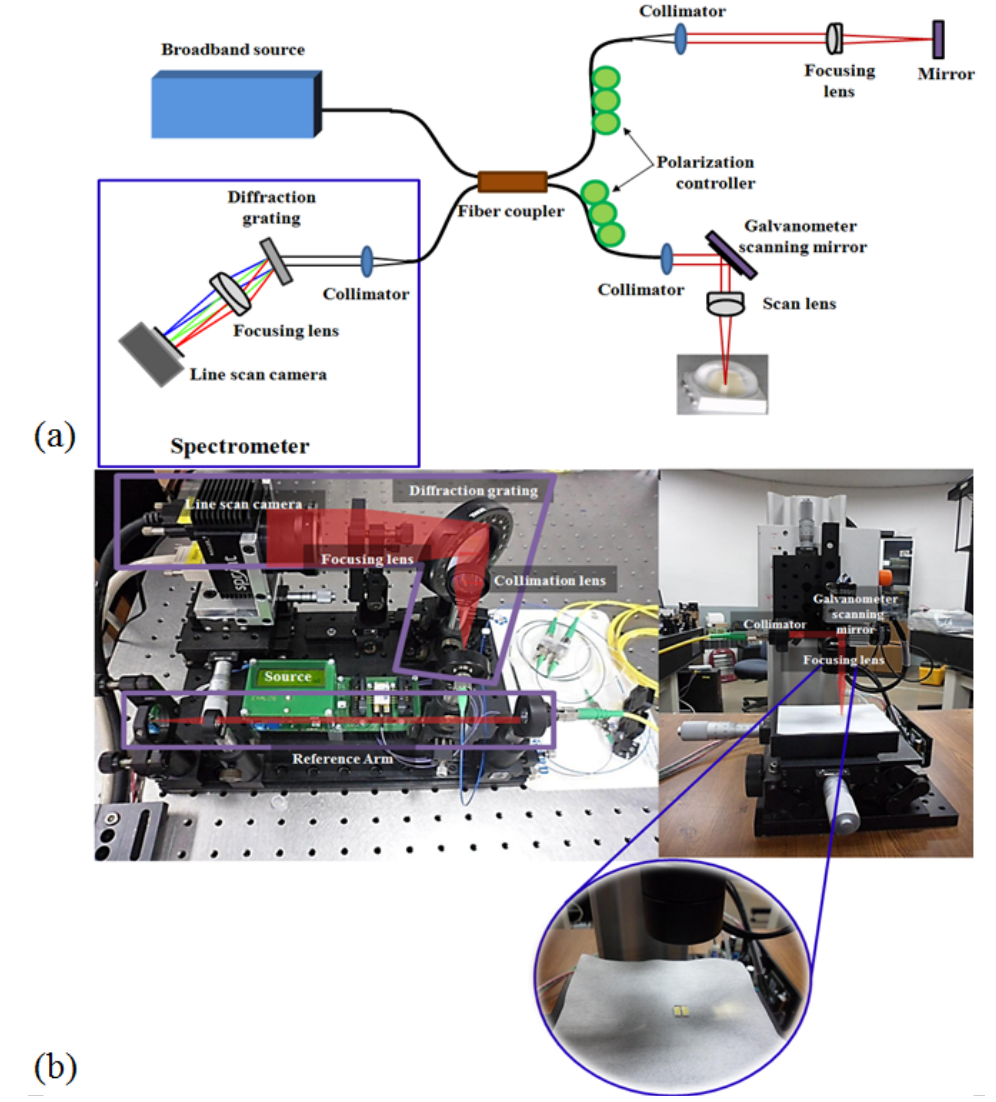
Figure 2. 850 nm SD-OCT system. ( a ) Schematic diagram of the SD-OCT system; ( b ) Photograph of 850 nm SD-OCT system and sample arm optic